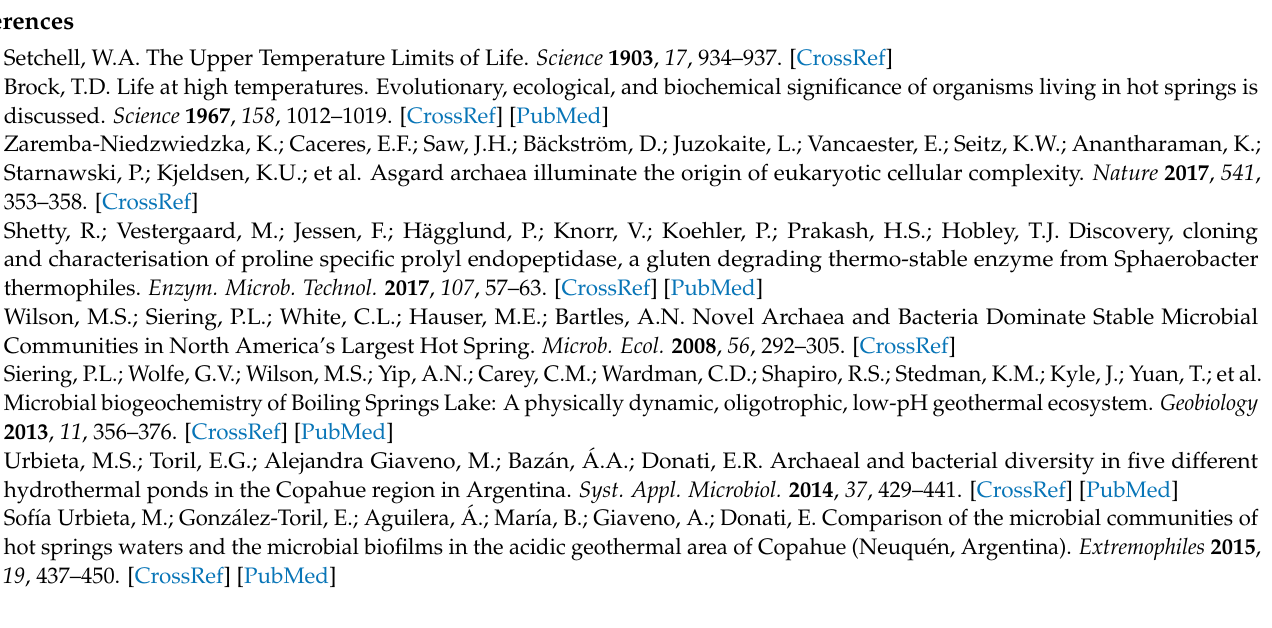
Table S6: Statistics and taxonomy (SILVA) of the recovered SSU rRNA gene sequences from C01–C19; Table S7: Comparison of SSU rRNA sequences from FAU and TRT with SSU rRNA sequences from C01–C19; Table S8: Comparison of sequences of genes—coding for ribosomal proteins extracted from MAGs of FAU and TRT—with sequences of metagenomes from